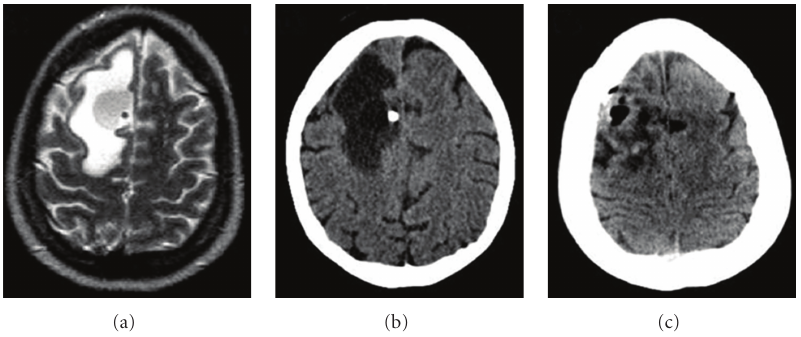
Figure 2: Patient B’s imaging: (a) T2 MRI of the brain on admission. (b) CT of the brain on admission. (c) CT on postoperative day two, which shows resolution of the cyst and the white matter